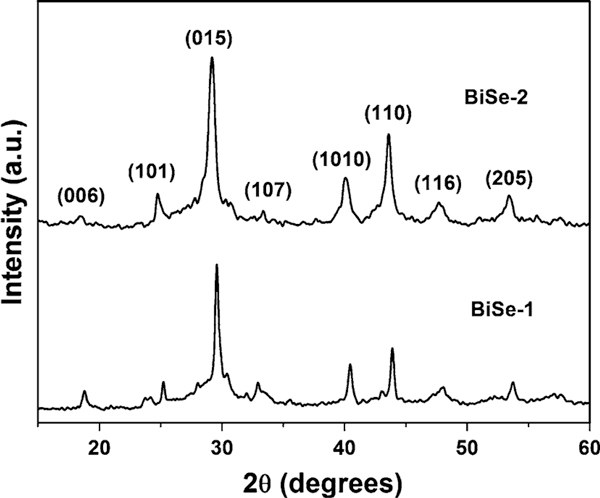
XRD patterns of the as-prepared Bi2Se3 samples synthesized in DMF for 24 h, BiSe-1 at 140°C, and BiSe-2 at 200°C.